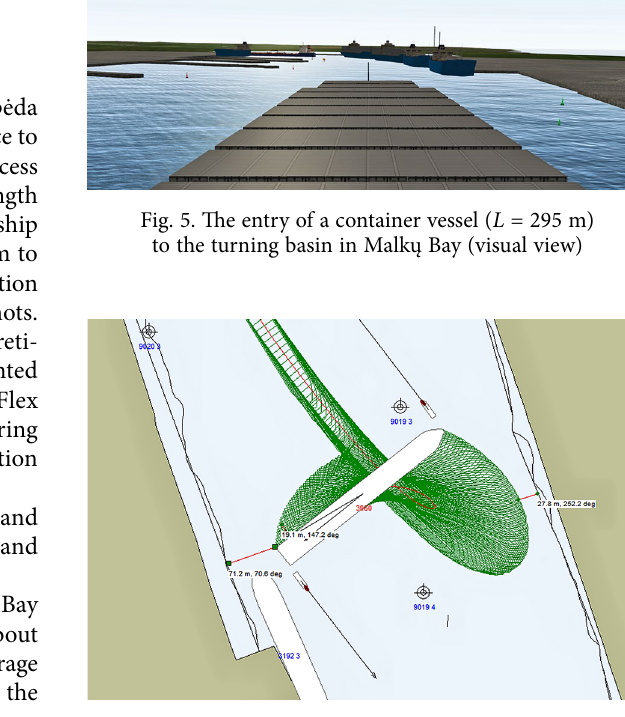
Fig. 6. A turn of a container vessel ( L = 295 m) into the ship turning basin in Malkų Bay employing 2 × 50 T bollard pull tugboats (electronic